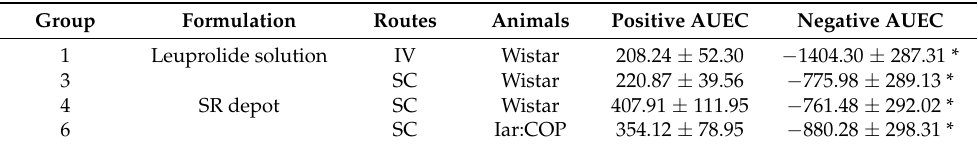
Table 3. The drug-specific AUEC separated by positive and negative AUEC for each group (mean ± SE, n =